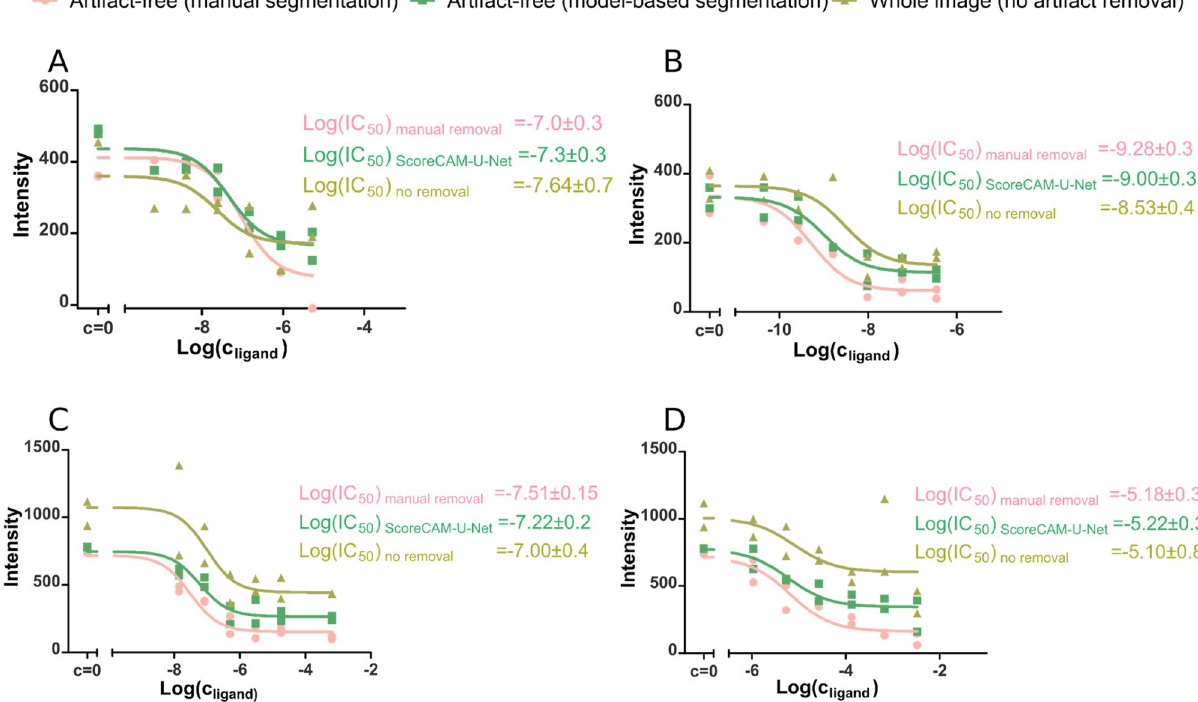
Figure 6. Cell fluorescence intensity dependence on M4 receptor ligand concentration determined with live- cell fluorescence microscopy at the presence of 2 nM UR-CG072. Displacement curves of three different ligands are shown: pirenzepine ( A , C ), atropine ( B ) and arecholine ( D ). Three different artifact removal methods at the image analysis stage are compared (colors): manual artifact segmentation, ScoreCAM-U-Net segmentation and no artifact removal. For each combination of ligand and artifact removal method a regression analysis is performed with Hill equation (Hill coefficient fixed at − 1) with the best fits shown as continuous lines. For each displacement curve, the Log(IC 50 ) ± SD is presented, where SD represents the standard deviation estimation of Log(IC 50 ). Each displacement curve was measured in duplicates with each data point representing the average fluorescence intensity of cells in each